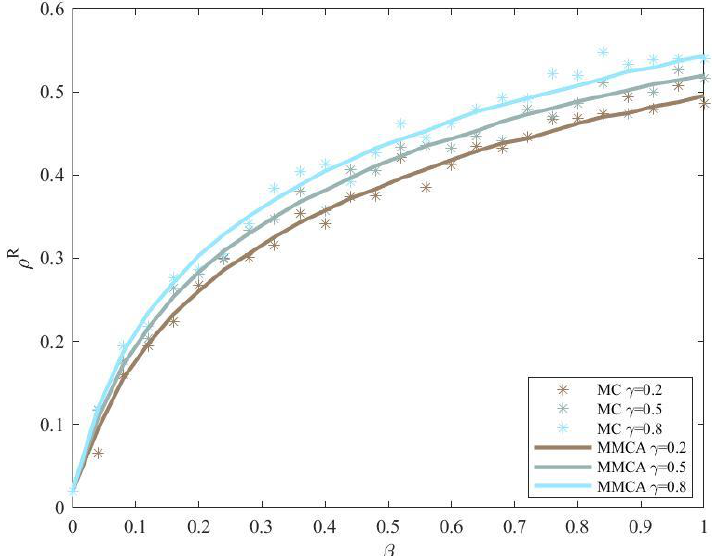
Figure 6. Comparison of MC simulation and MMCA results. The parameters are as follows: p = 0.5, q = 0.5, α = 5, m = 2, m 1 = 5, m 2 = 7, κ = 2, η = 0.8, µ = 0.8, λ = 0.8, δ = 0.2, θ =